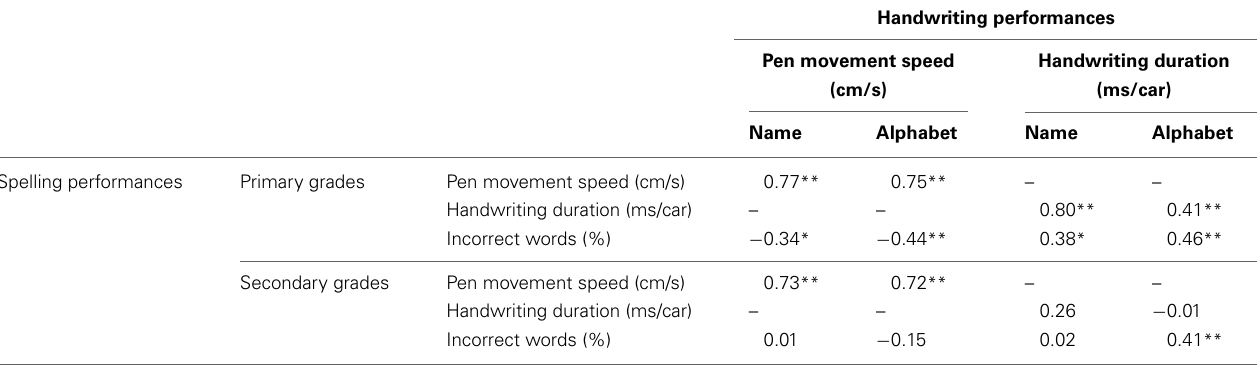
Table 3 | Pearson correlation coefficients (r) and probability for primary and lower secondary groups between handwriting performances (pen movement speed (cm/s) and handwriting duration (ms/car), in the name writing and alphabet writing tasks) and spelling performances [% of incorrect words, pen movement speed (cm/s) and handwriting duration